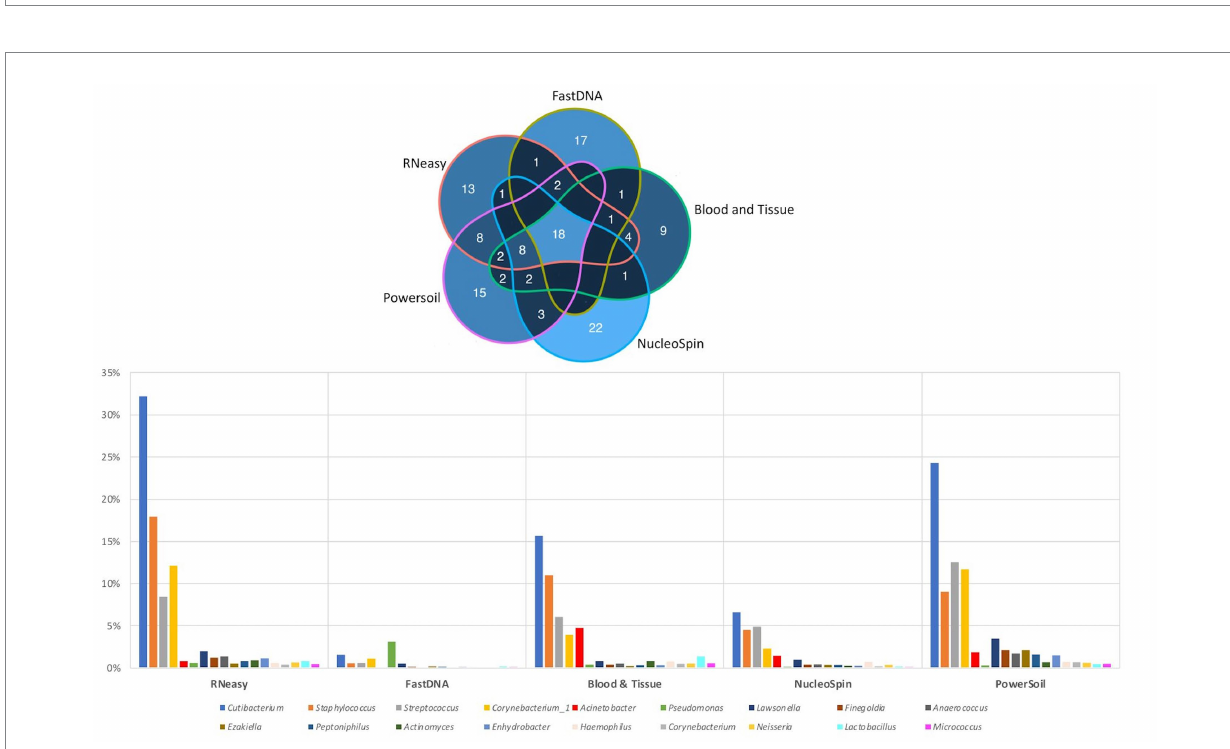
FIGURE 6 Top 20 genera per volunteer per extraction protocol. Top: Venn diagram depicting the number of overlapping genera between different extraction protocols (not taking into account the host DNA depletion kits). Calculated by looking at the top 20 per volunteer per protocol, 18 genera were extracted by all protocols. Bottom: Distribution, by means of relative abundance, of the 18 genera in common per extraction protocol. The six core genera as described in our earlier paper (Delbeke et al., 2021) can be extracted by all protocols. Bacillus was not part of these 18 genera.